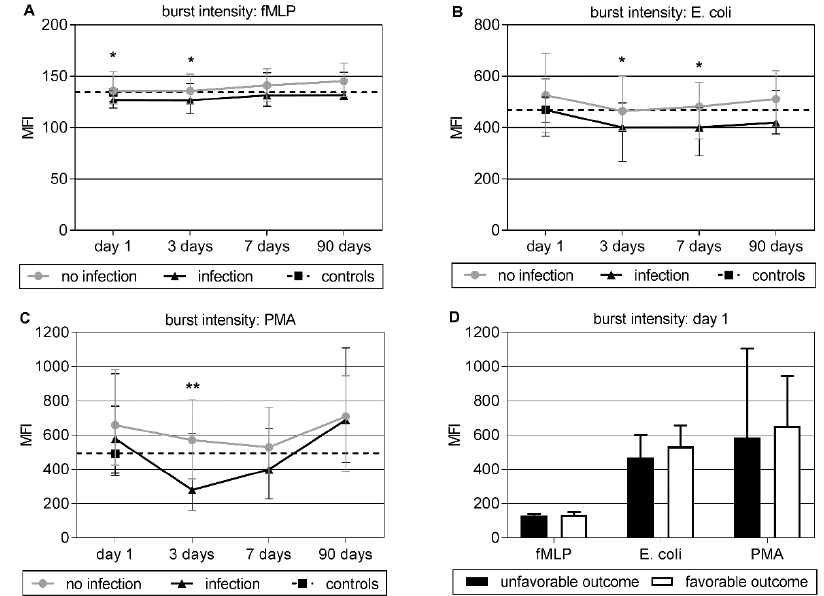
Figure 1. ( A – C ) Time course of neutrophil oxidative burst intensity, represented by the mean fluorescence intensity (MFI), under di ff erent stimuli with formyl-methionyl-leucyl-phenylalanine (fMLP), E. coli and phorbol 12-myristate 13-acetate (PMA) for patients without infection (dot), patients with infection (triangle), and controls (black square). Given are group medians and interquartile ranges. For better comparison, the control level is plotted as a dotted line over the entire time course. Significant results in day-by-day group comparison by Mann–Whitney U testing are marked as * for p < 0.05 and ** for p < 0.01. ( D ) Burst intensity under di ff erent stimuli at baseline (day 1) for the two outcome groups. There were no significant di ff erences between